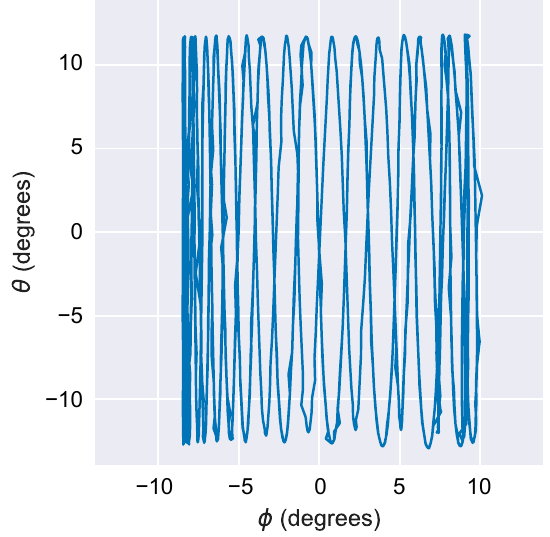
Figure 10. Two-axis actuation demonstration.